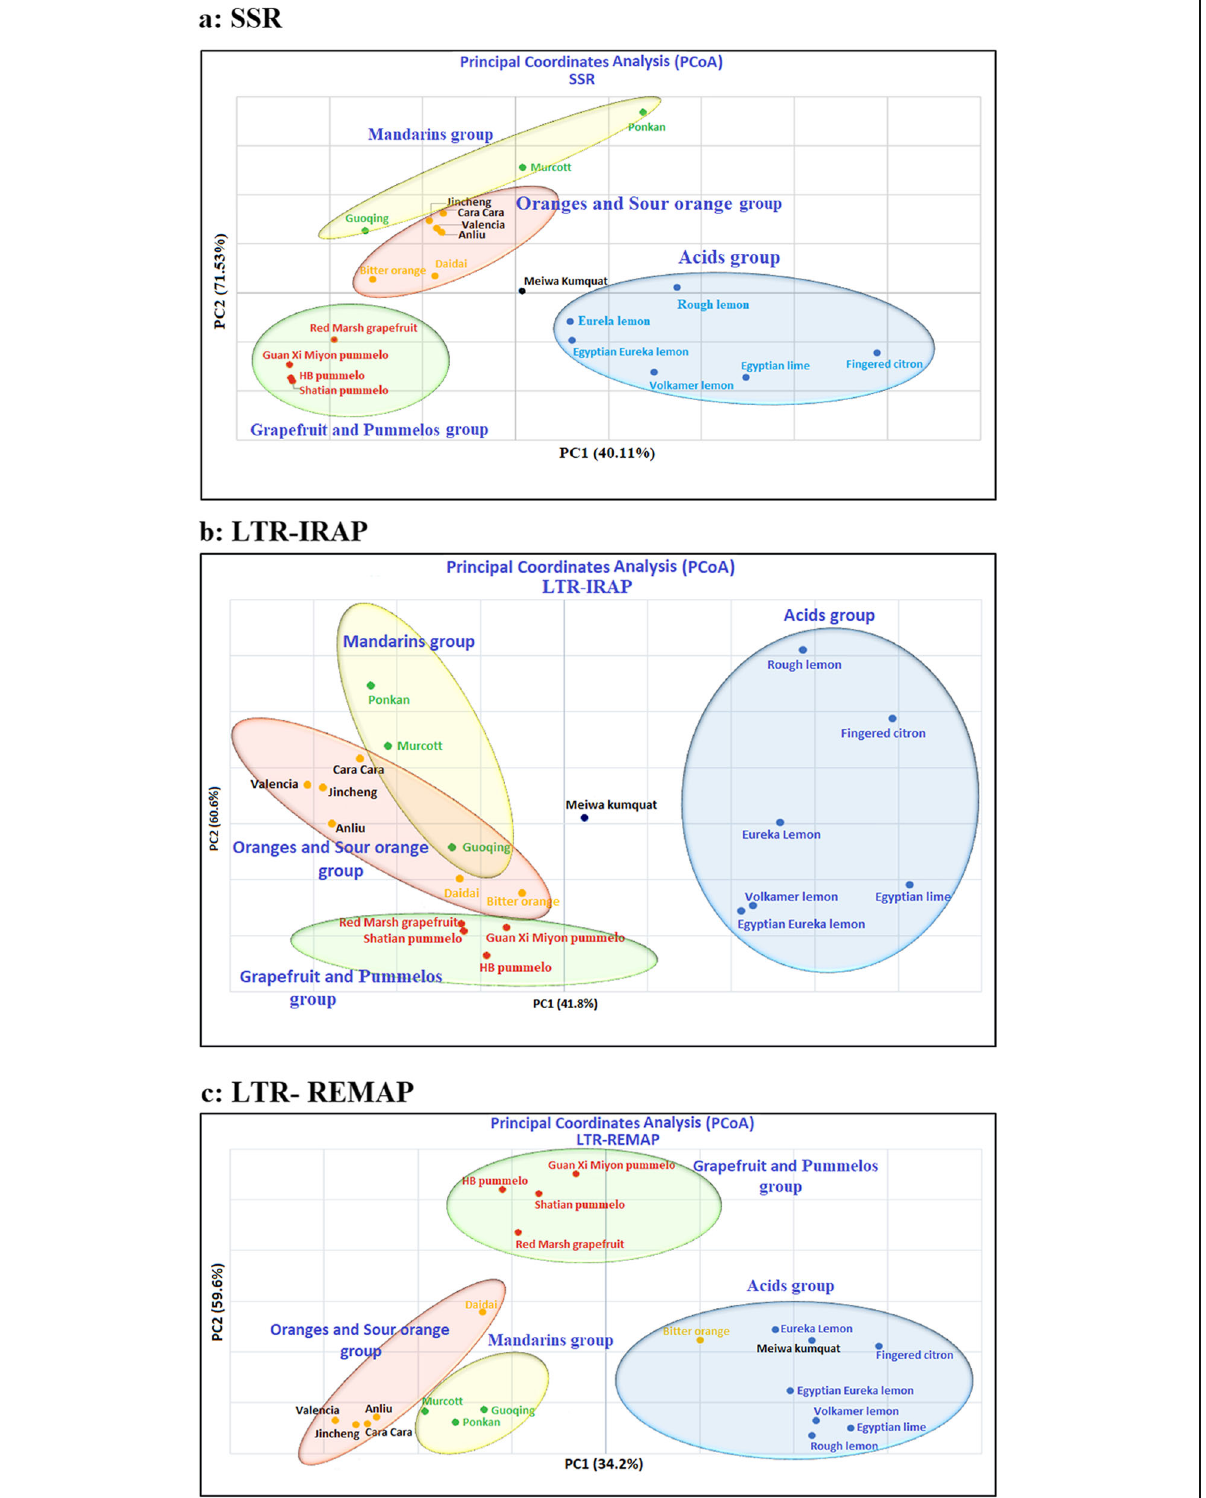
Fig. 3 Schematic representation the principal coordinate analysis (PCoA) among 20 genotypes of citrus and its relatives species via a SSR, b LTR- IRAP, and c